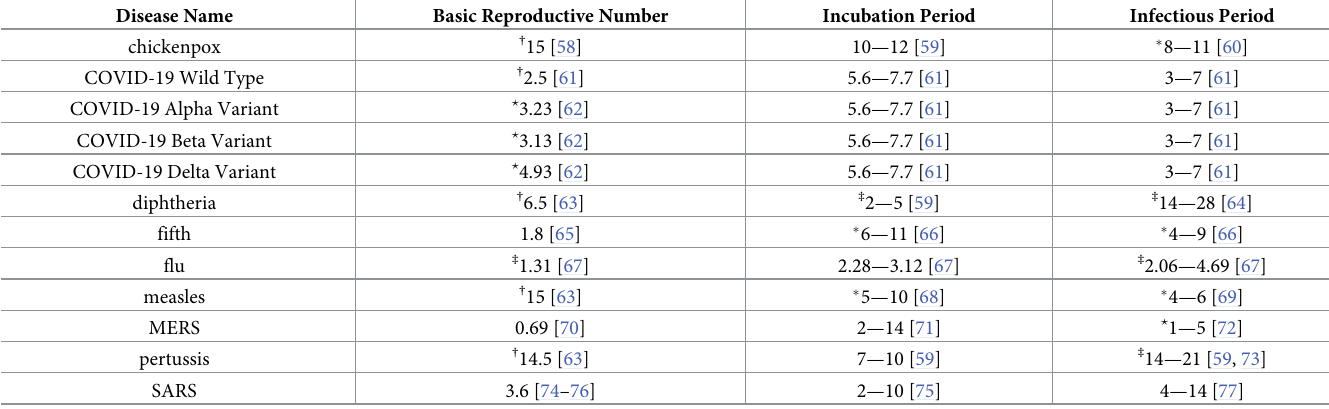
Table 1. Disease parameter table. Disease